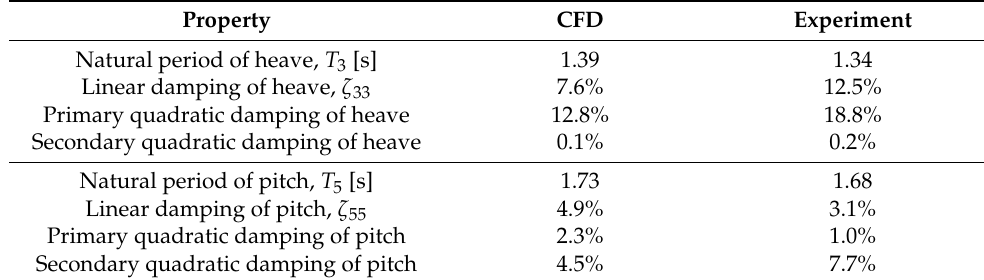
Table 4. Comparison of the free decay test results for heave and pitch from experiments and CFD calculations.